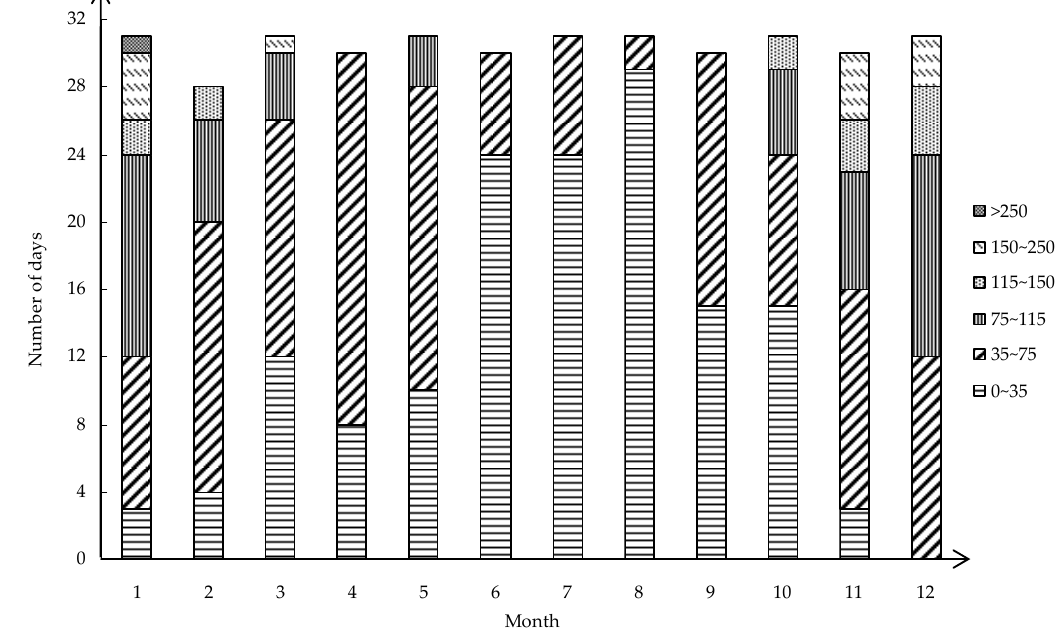
Figure 4. The number of days in each concentration interval of PM 2.5 in each month of 2017.